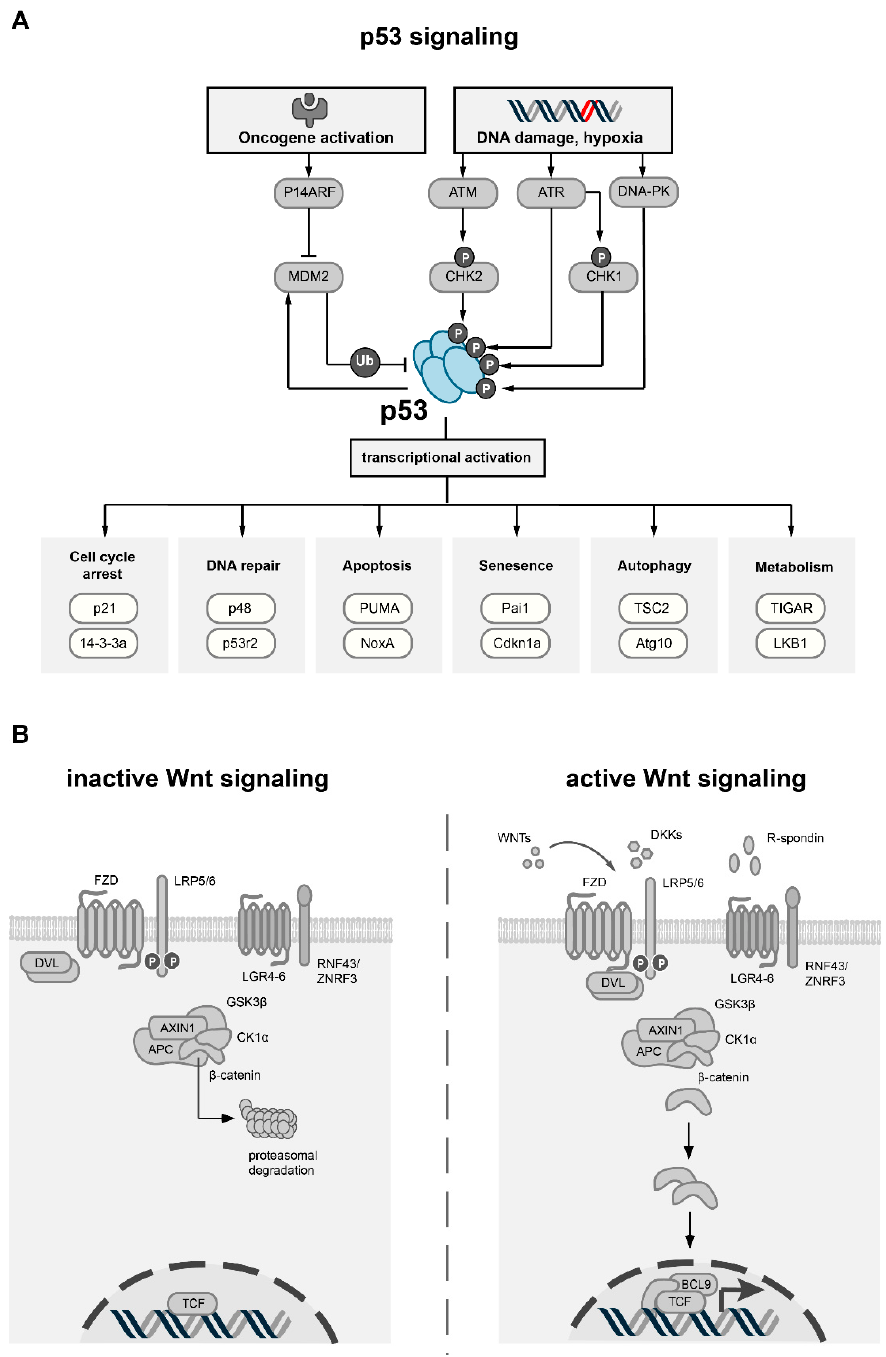
Figure 1. Overview of the p53 and Wnt pathway. ( A ) Schematic overview of p53 activation, regulation and transcriptional targets. Stress stimuli such as DNA damage or oncogene activation result in the activation of specific effector proteins (ATM, ATR, DNA-PK, CHK1/2, P14ARF), which stabilize p53 through phosphorylation or by inhibition of MDM2, the main negative regulator of p53. p53 itself can increase expression of MDM2, thereby creating a negative feedback loop. Activation of p53 increases the transcriptional activity of many target genes which are involved in key cellular processes (exemplary processes with target genes are shown). ( B ) Schematic overview of canonical Wnt signaling. In the inactive state ( left ), the absence of WNT ligands results in the phosphorylation of β -catenin by the destruction complex, which comprises the scaffold protein AXIN1, APC, GSK3 β and CK1 α . Upon phosphorylation by GSK3 β , β -catenin is ubiquitinated and